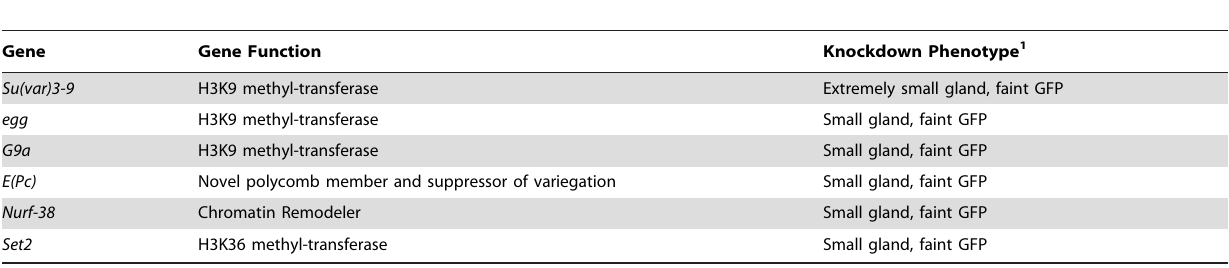
Table 1. Genes recovered in an RNAi screen for salivary gland cell death.